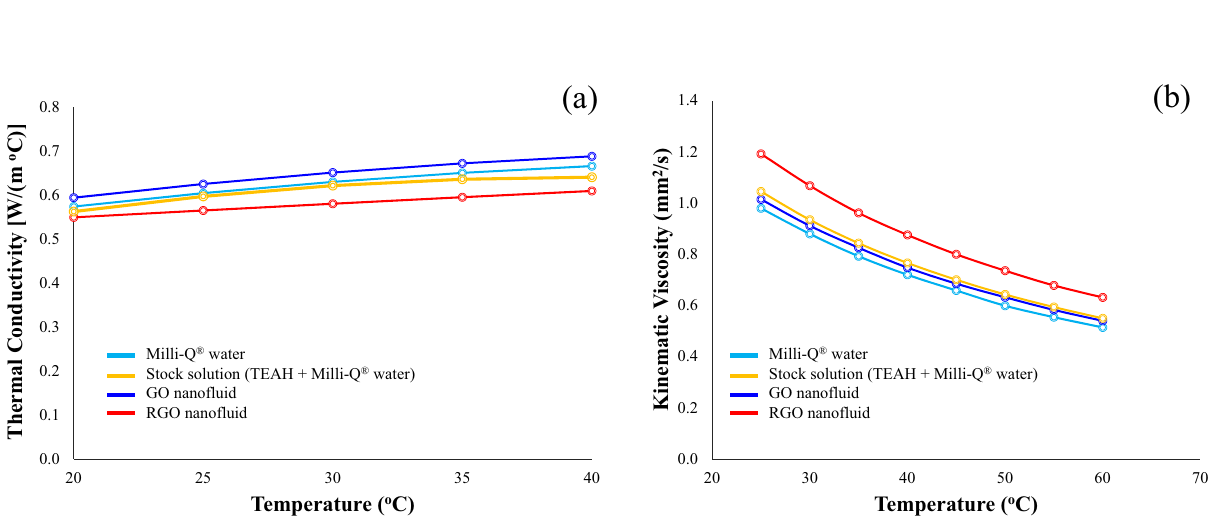
Table 2. Band gap energy values ( Eg ), indirect (I) and direct (D), obtained from Tauc plots of GO and RGO based aqueous nanofluids.